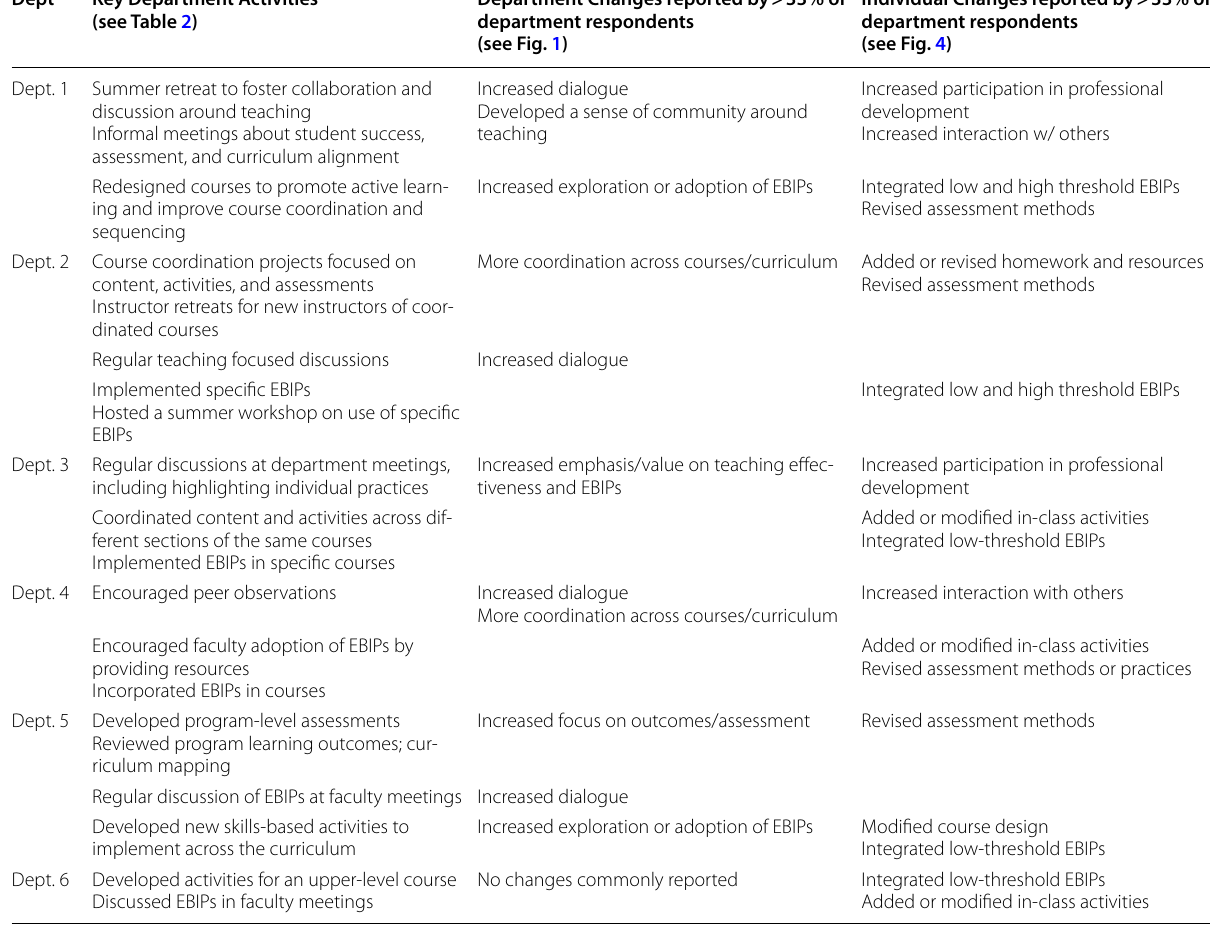
Table 5 Comparison of department activities and changes reported by more than a third of department respondents